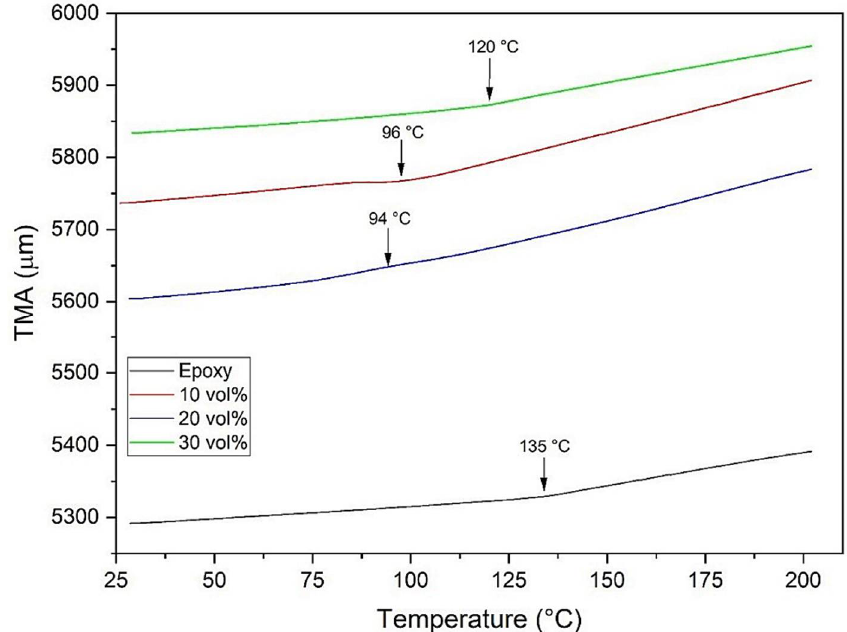
Figure 9. TMA curves obtained for epoxy resin and kenaf composites.